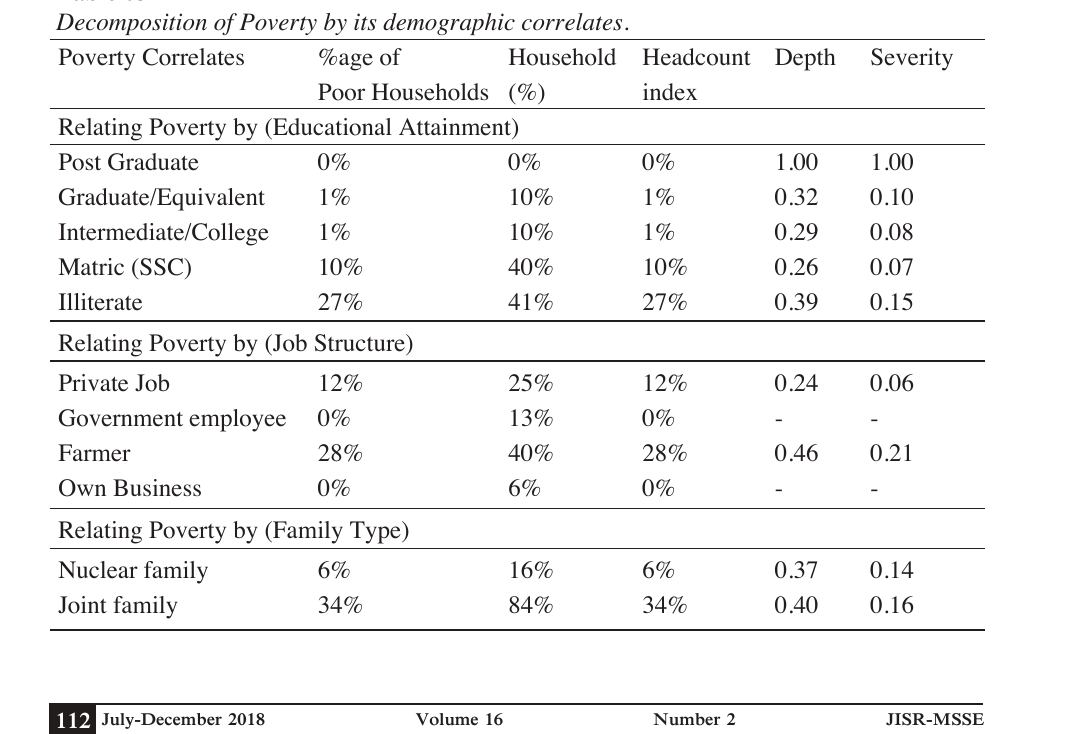
Decomposition of Poverty by its demographic correlates. Poverty